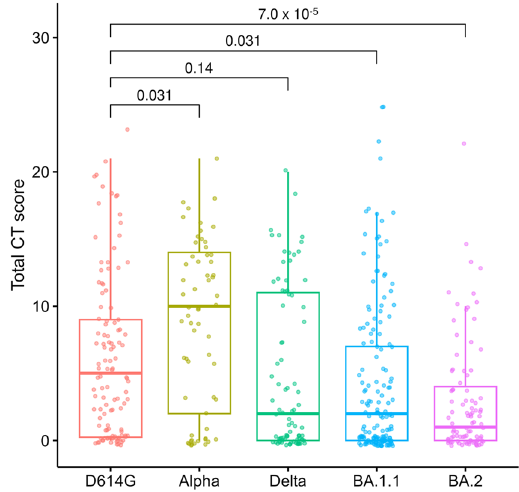
Fig. 3 Relationship between SARS-CoV-2 variant and CT score. The CT scores were evaluated semi-quantitatively based on the percentage of lung involvement in the fi ve lung lobes, and the sum of the CT scores (total CT score) was calculated. Box plots show the total CT scores of D614G ( n = 114), Alpha ( n = 61), Delta ( n = 84), BA.1.1 ( n = 163), and BA.2. ( n = 92). Each box indicates the interquartile range (top: the third quartile; bottom: the fi rst quartile) with a horizontal line indicating the median. Statistical analysis was performed by a t -test, and P- values were adjusted for multiple